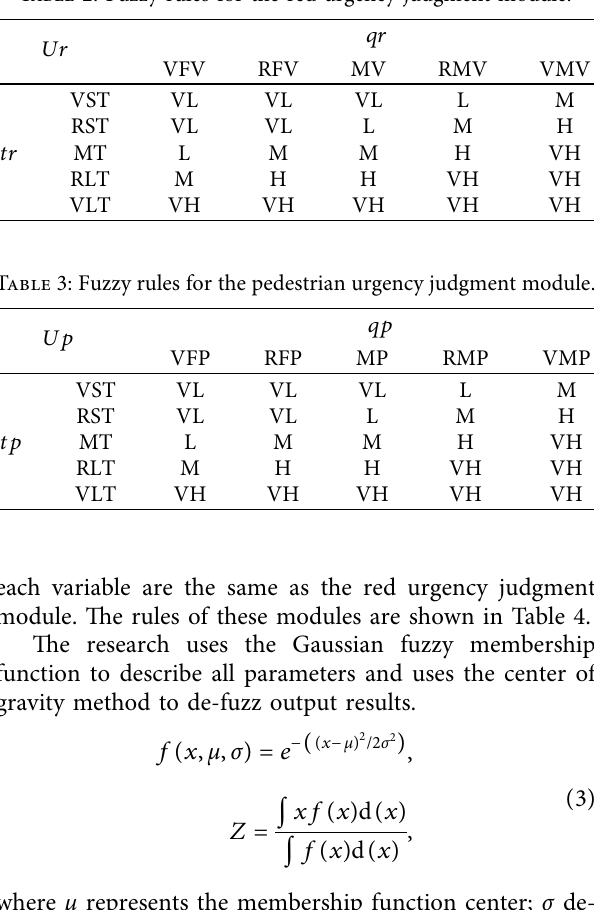
Figure 2: The diagram of adaptive two-stage fuzzy controller. Table 2: Fuzzy rules for the red urgency judgment module. Table 4: Fuzzy rules for the green urgency judgment